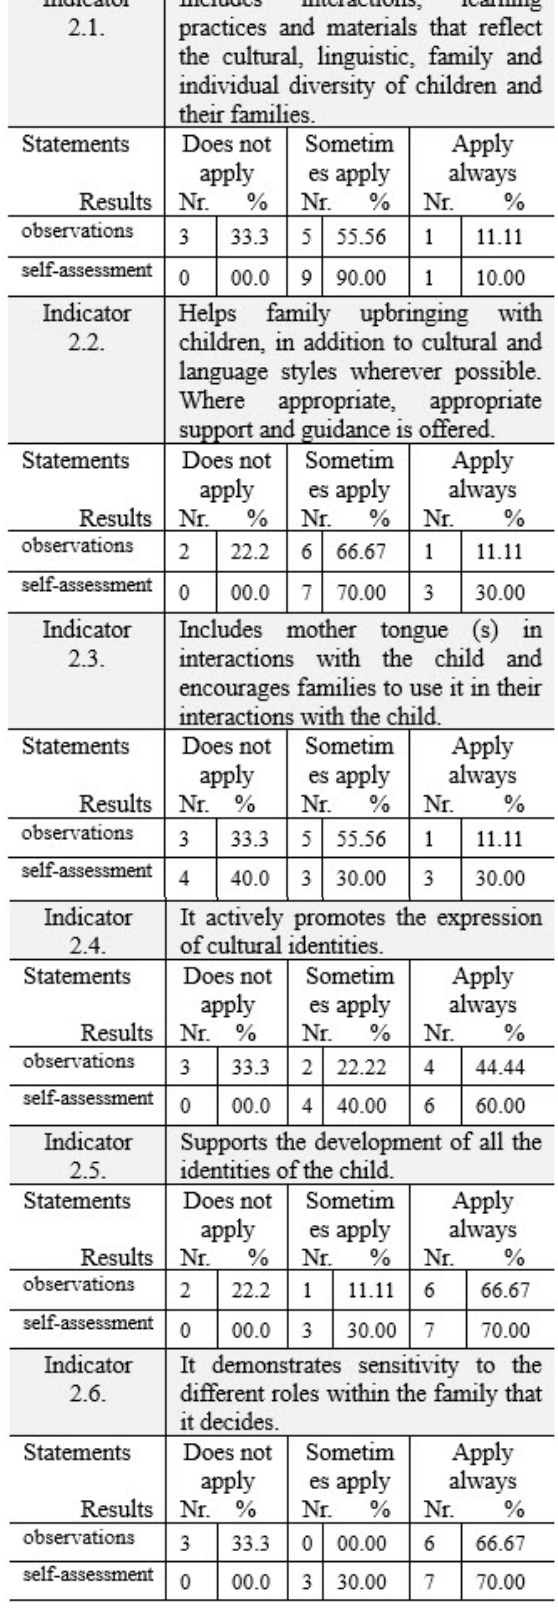
Table 11. Principle 2: Understand - ing and appreciating the diversity that exists among children, families and communities builds childhood